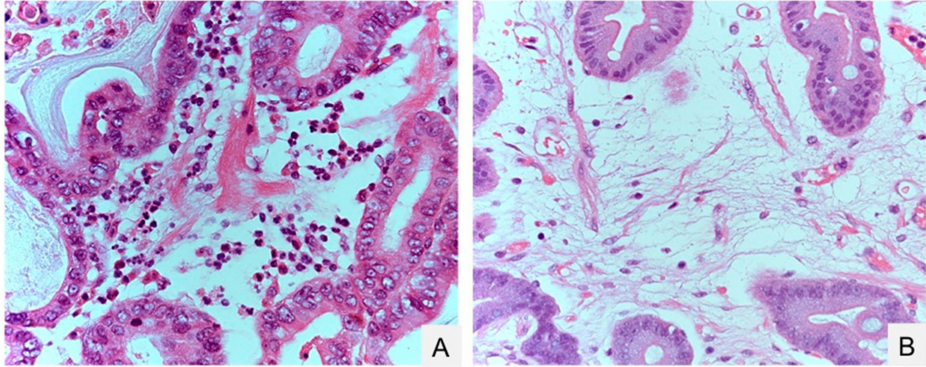
Figure 1. Gastric inflammation before and after eradication of Helicobacter pylori . ( A ) Neutrophil inflammation before H. pylori eradication; ( B ) edematous stroma after H. pylori eradication. Hematoxylin-Eosin (HE) staining. Original magnification, 400 × ( A , B ).